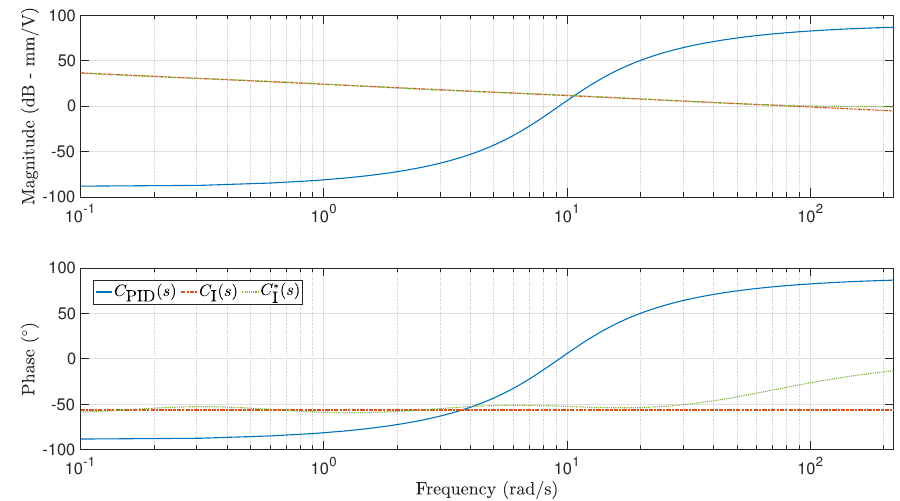
Figure 9. Frequency response of the designed integer and fractional order controllers.